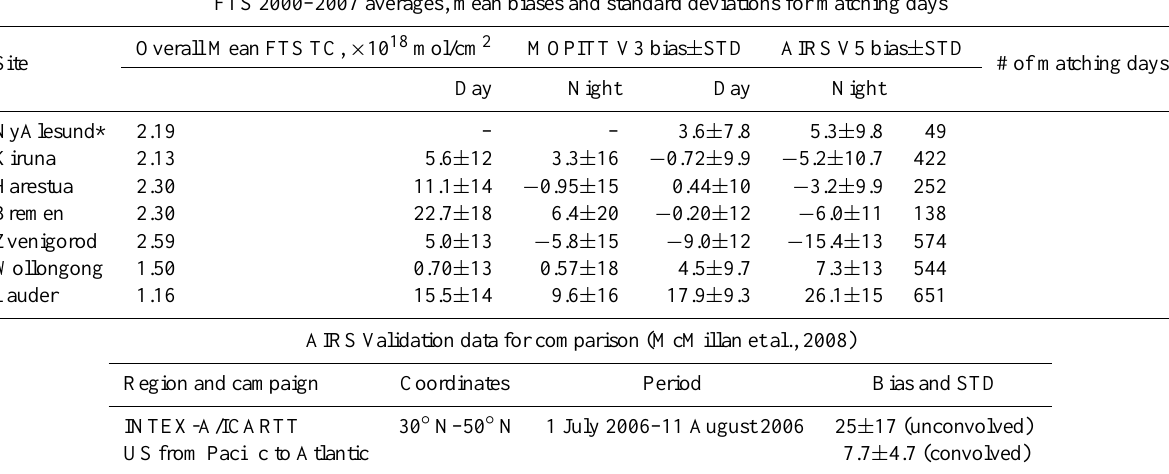
FTS 2000–2007 averages, mean biases and standard deviations for matching days